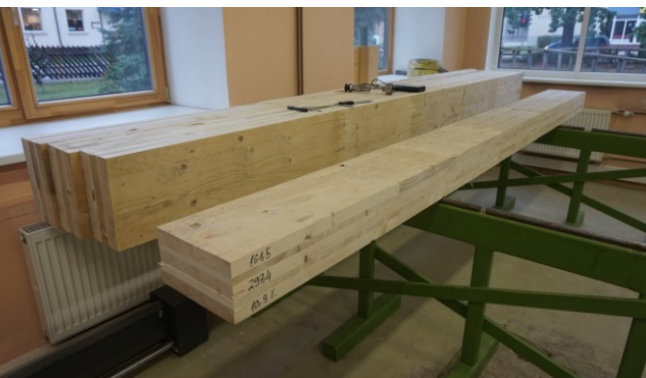
Figure 6. Preparation of sample and performance of measurements (sample dimension and relative humidity measurements).